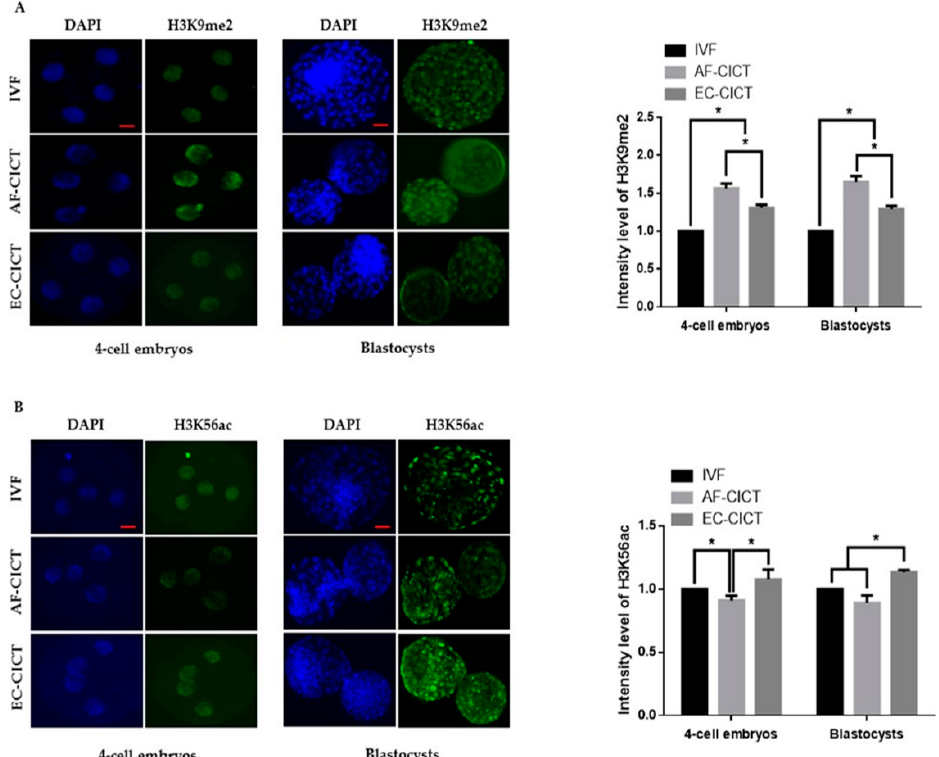
Figure 4. Global methylation levels of H3K9 and acetylation levels of H3K56 in IVF and CICT embryos. ( A ) Representative immunofluorescence images of H3K9me2 in embryos at the four-cell and blastocyst stage. Embryos were stained for H3K9me2 (green) and DNA (DAPI, blue). Bar = 100 µ m. Quantification of fluorescence intensity at the four-cell and blastocyst stage ( n = 10 per group). ( B ) Representative immunofluorescence images of H3K56ac in embryos at the four-cell and blastocyst stage. Embryos were stained for H3K56ac (green) and DNA (DAPI, blue). Bar = 100 µ m. Quantification of the fluorescence intensity at the four-cell and blastocyst stage ( n = 10 per group). Labeling intensity was expressed relative to that of the IVF group (set as 100%). The data are from three independent experiments and are means ± SEM (* p < 0.05).